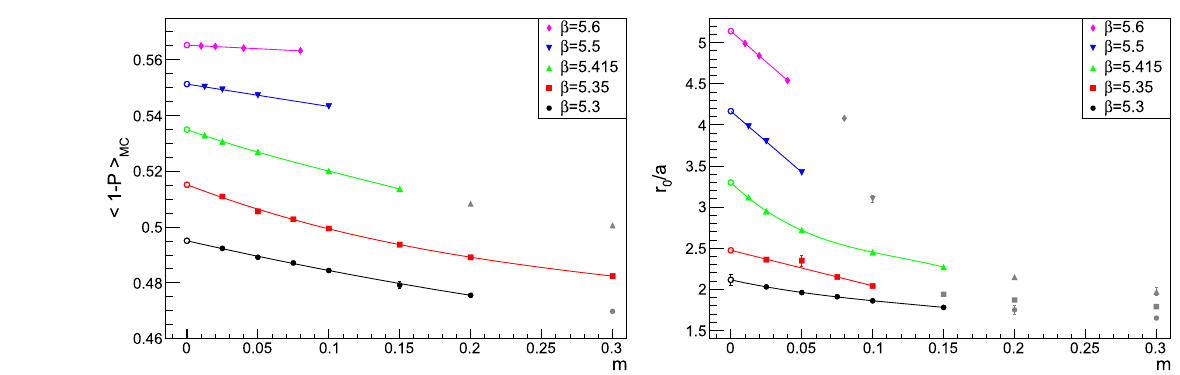
Fig. 12 Chiral extrapolation of the nonperturbative plaquette (left panel) and the ratio r 0 / a (right panel) at five different values of β . The grey points are available from Ref. [50] but are excluded because